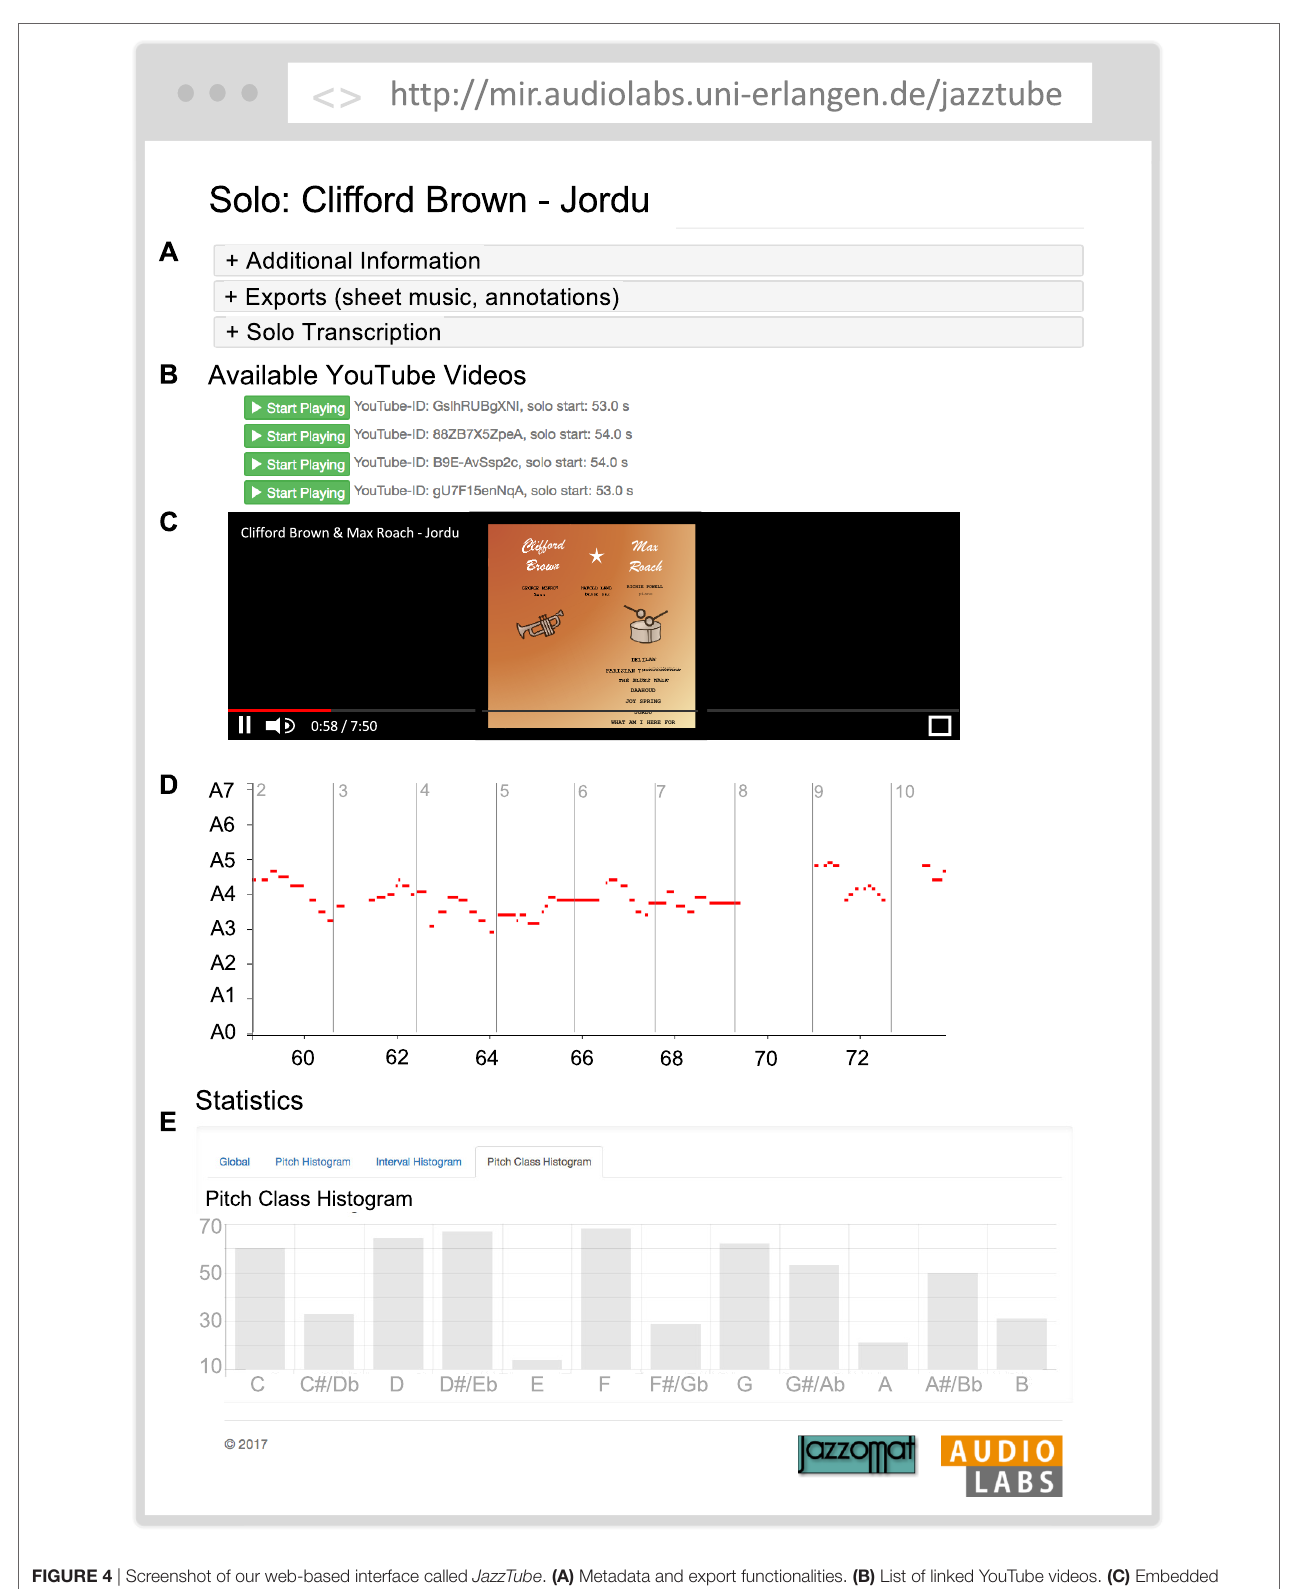
FigUre 4 | Screenshot of our web-based interface called JazzTube . (a) Metadata and export functionalities. (B) List of linked YouTube videos. (c) Embedded YouTube video. (D) Piano-roll representation of the solo transcription synchronized with the YouTube video. (e) Additional statistics. Panel (c) has been created by the authors and, therefore, no permission is required for its use in this manuscript